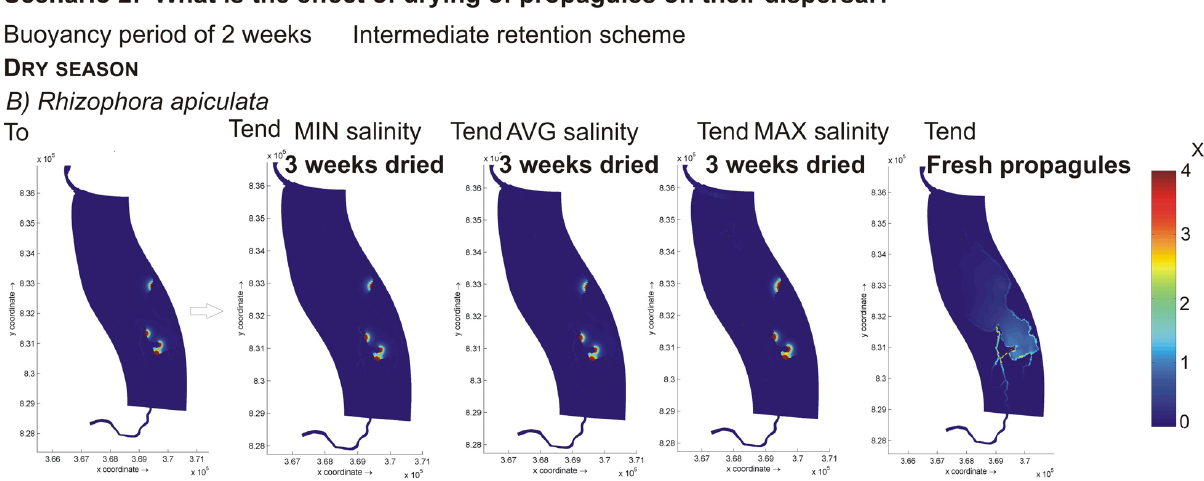
Fig. 6b. Results of scenario 2 (effect of drying) showing the distribution plots of Rhizophora apiculata in the dry season. Red, yellow and light blue colours indicate a high, medium and low concentration of propagules